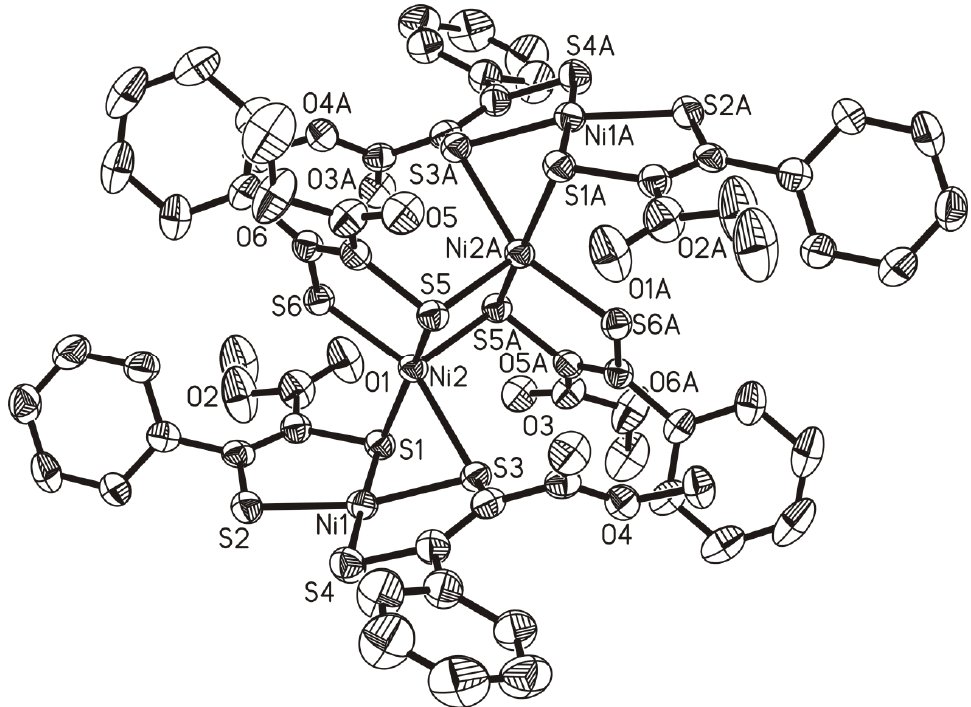
Figure 2. Molecular structure of the di-anion of 4·2CH 3 CN·2Et 2 O shown with 50% probability thermal ellipsoids (the two potassium counter cations, disordered minor occupancies, H atoms, and lattice solvents are omitted and only heteroatom labels are shown for clarity reasons; see the Supplementary Material, Figure S16, for a fully labeled version; label extension A refers to symmetry (1 − x, 1 − y, 1 − z) generated atoms).